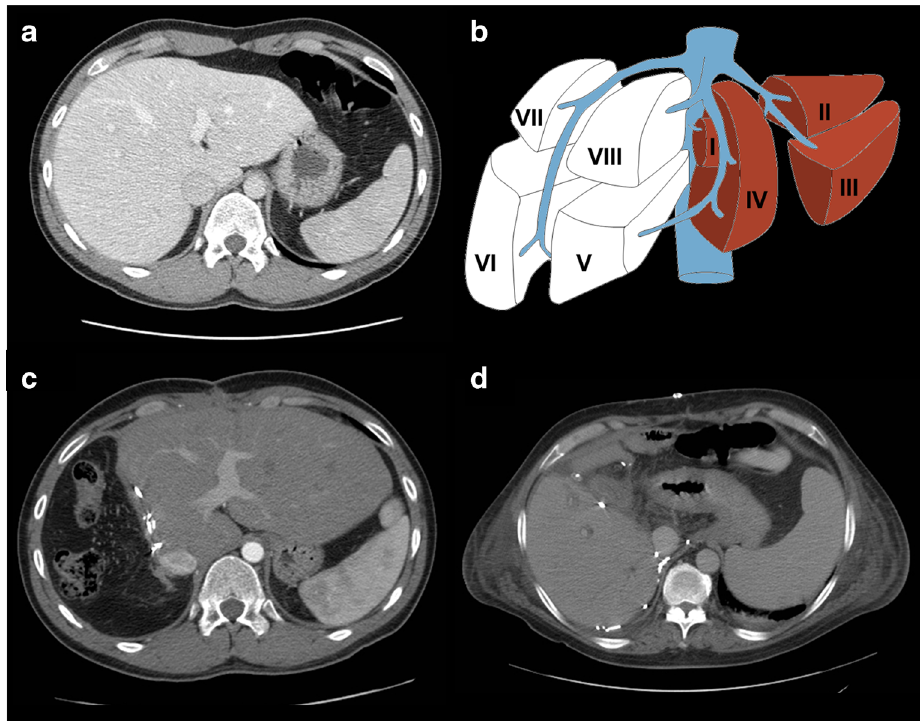
Fig. 6 Size incompatibility after living donor liver transplantation: both the donor and the recipient suffered transient hepatic insufficiency. a Axial enhanced CT image of a 26-year-old living liver donor. The total liver volume (TLV) was 1,754 mL. The donated liver volume was 980 mL and the residual liver volume was 774 mL (44.2% of the TLV). b Diagram showing the intended right split liver surgery planned for